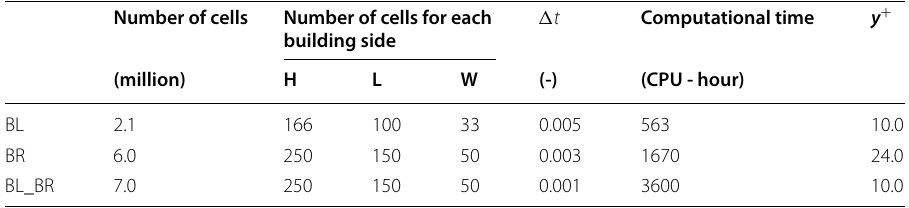
Table 4 Error metrics of ¯ C p , C ′